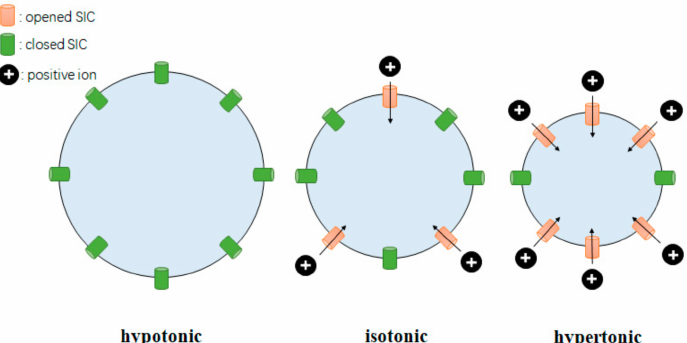
Figure 5. MNCs SIC channel and permeability sensitivity. The diagram shows that hypotonic swelling decreases the probability of SIC channel opening, whereas hypertonic contraction leads to an increase in the same